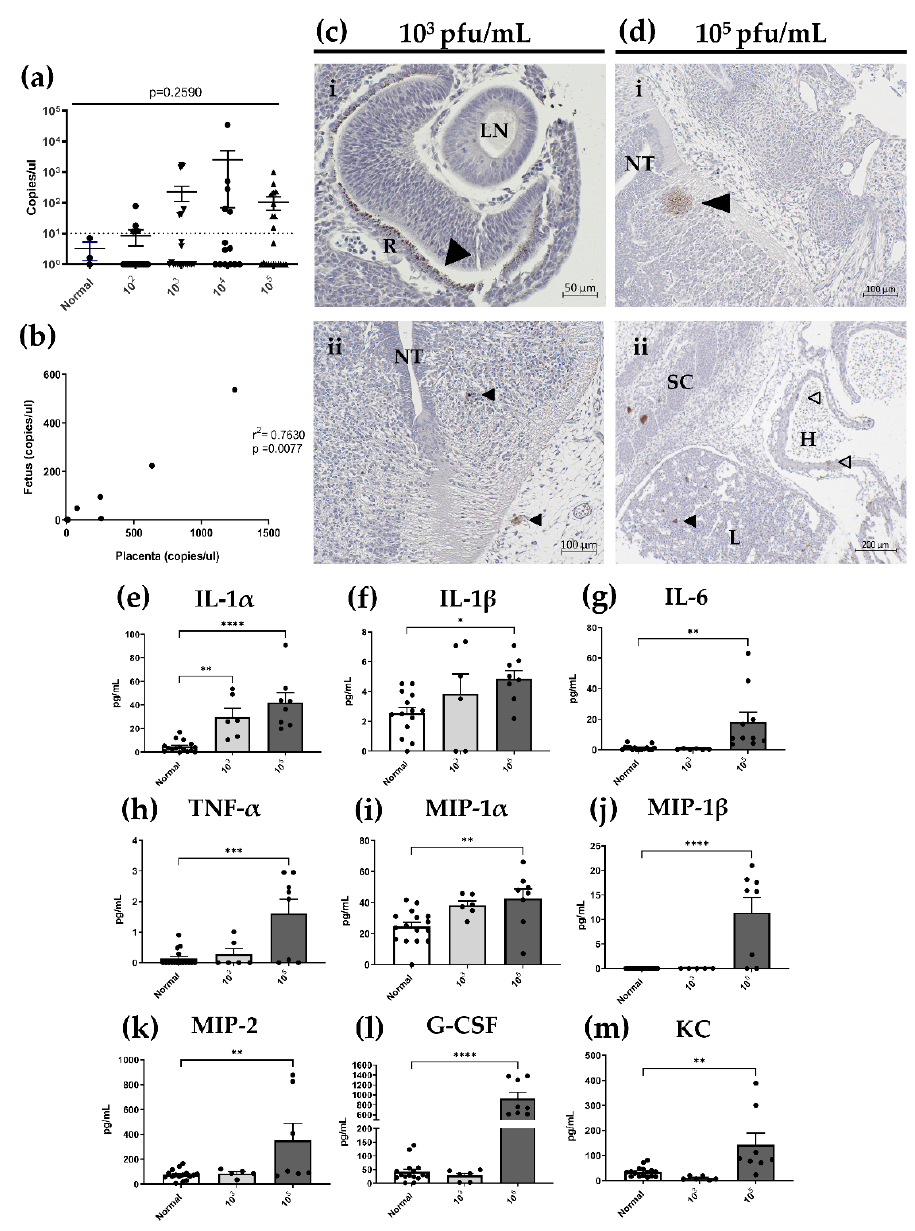
Figure 8. In utero HSV ‐ 2 transmission into fetuses results in congenital HSV ‐ 2 infection and in ‐ flammatory responses at gd12.5. ( a ) HSV ‐ 2 DNA was detected in fetal homogenates by qPCR with comparable levels for all viral doses. ( b ) There was a significant correlation between HSV ‐ 2 DNA levels in matched fetal and placental tissues, but HSV ‐ 2 DNA was not detected in fetal homoge ‐ nates in the absence of placental infection. Detection of HSV ‐ 2 DNA in placental tissues did not guarantee HSV ‐ 2 detection in matched fetal homogenates. ( c ) In fetuses from mice infected with low dose HSV ‐ 2 (10 3 pfu/mL), HSV ‐ 2 was detected in (i) the developing retina and (ii) neuroepi ‐ thelium surrounding the neural tube (arrowheads). ( d ) HSV ‐ 2 staining in fetuses from mice in ‐ fected with high dose HSV ‐ 2 (10 5 pfu/mL) showed disseminated expression of HSV ‐ 2 in fetal tis ‐ sues including the (i) neuroepithelium around the neural tube (arrowhead), (ii) heart (open arrow ‐ heads), and liver (closed arrowhead). ( e ) IL1 α expression levels were significantly increased com ‐ pared to controls in fetuses from mice infected with both low (10 3 pfu/mL) and high (10 5 pfu/mL) dose HSV ‐ 2. ( f – m ) Expression of all other pro ‐ inflammatory cytokines and chemokines in fetal homogenates was significantly increased in fetuses from pregnancies complicated by high, but not low, dose HSV ‐ 2 infection. H: heart, L: liver, LN: lens, NT: neural tube, R: retina, SC: spinal col ‐ umn. Data expressed as mean ± SEM. * p < 0.05, ** p < 0.01, *** p < 0.001, **** p<0.0001